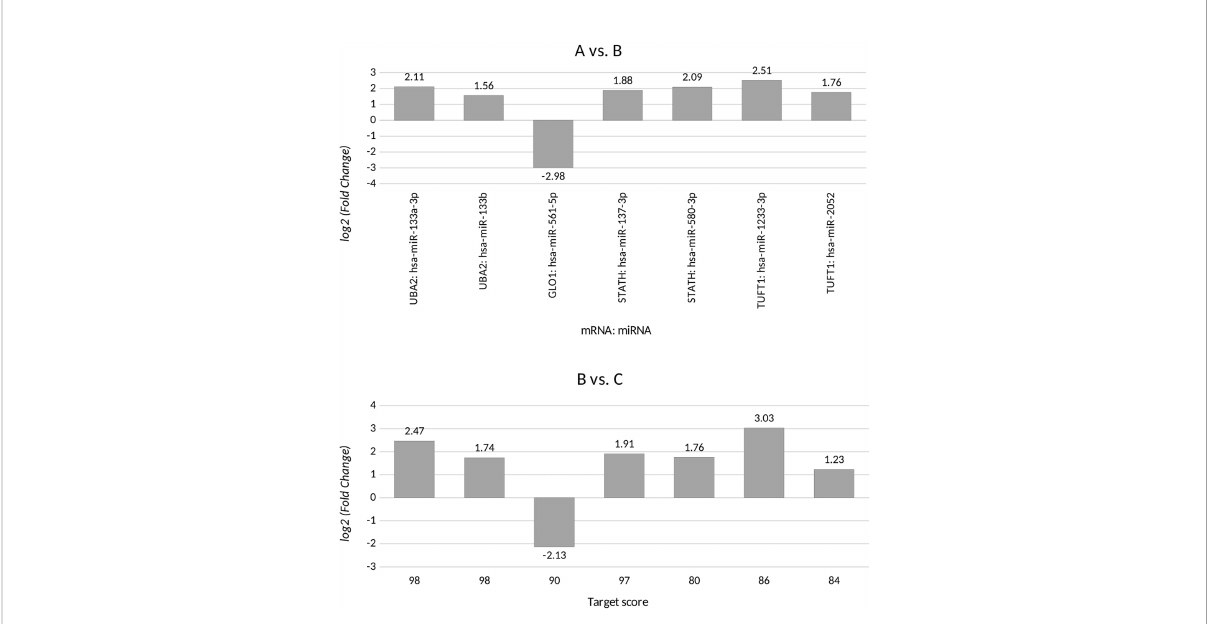
FIGURE 2 Changes in miRNA expression levels for differentiating ovarian cancer samples (groups A and B) from control samples (group C) that are potentially involved in regulating the expression of the selected transcripts, for UBA2 , ubiquitin-like modi fi er-activating enzyme 2; GLO1 , glyoxalase I; STATH , statherin, TUFT1 , tuftelin 1; RIC8A , RIC8 guanine nucleotide exchange factor B; ABCC5 , ATP-binding cassette subfamily C member 5; HPD , 4-hydroxyphenylpyruvate dioxygenase; GBF1 , Golgi brefeldin A-resistant guanine nucleotide exchange factor 1. (+), overexpression in comparison with the control; (-), downregulation in comparison with the